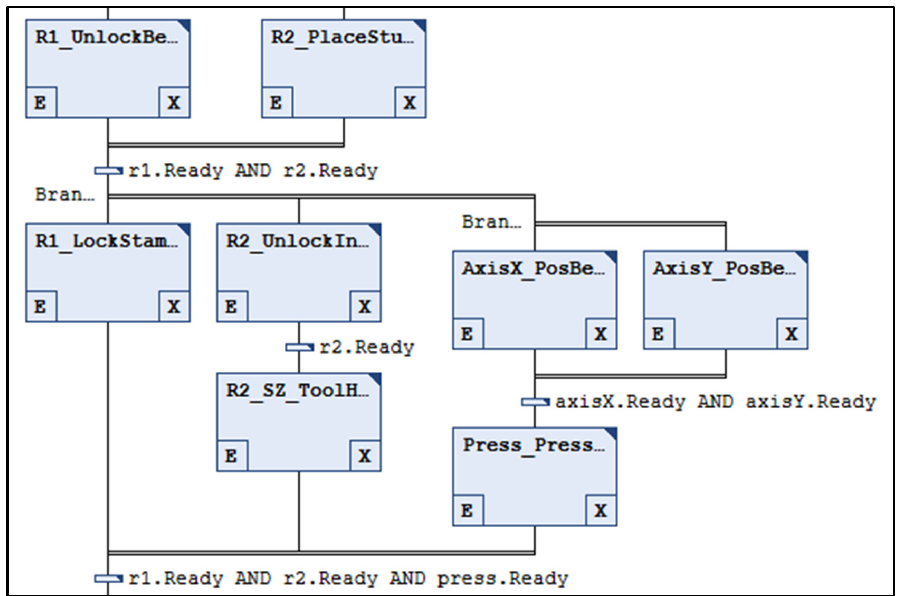
Figure 9. Portion of the PLC program developed for the robotic assembly test case.